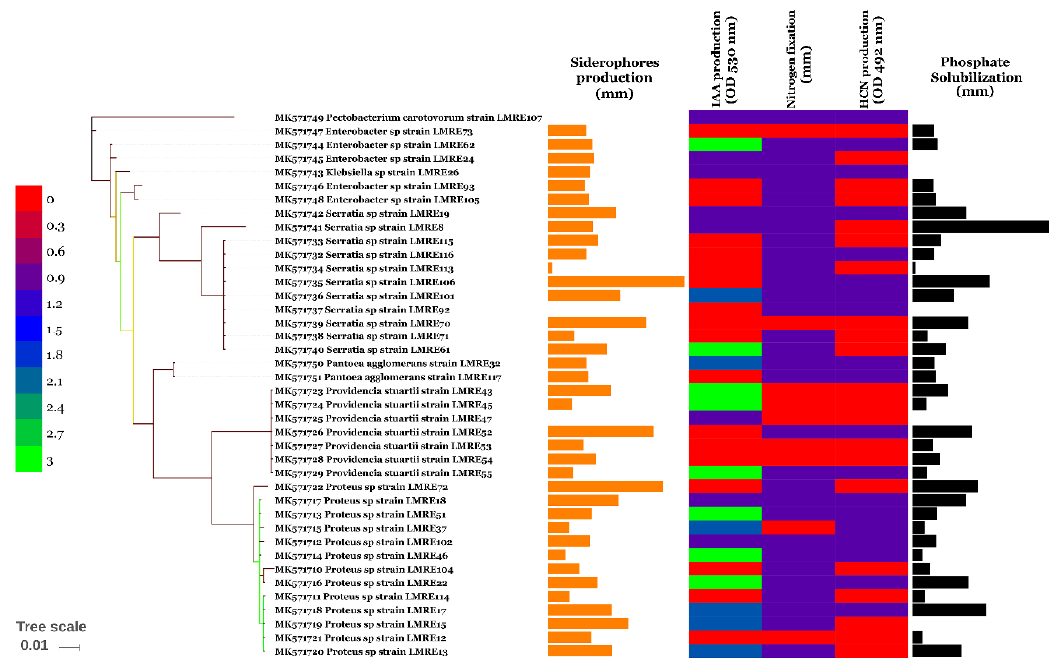
Figure 3. Enzyme activity (IAA production, Siderophore production, Phosphate solubilization, Nitrogen fixation Figure3. Enzymeactivity(IAAproduction, Siderophoreproduction, Phosphatesolubilization, and HCN production) of Gram-negative bacterial isolates.